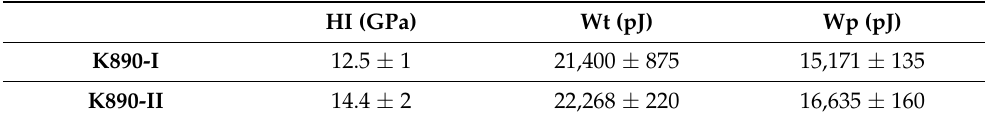
Figure 10. Gaussian distribution of HI ( a ) and Wt ( b ). In both graphs, the peak corresponds to the mean value and the curve amplitude to the standard deviation. Table 3. Indentation Hardness (HI), Total hardening Work (Wt) and plastic Work (Wp) obtained by nanoindentation tests (mean values and standard deviations).